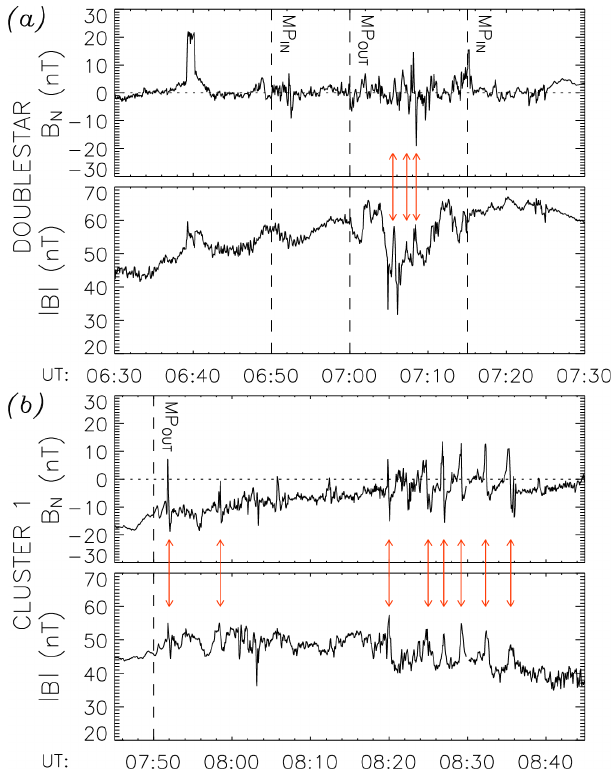
Fig. 3. Magnetic field measurements from the (a) TC-1 and (b) Cluster 1 spacecraft. The component of the magnetic field normal to the local magnetopause and the overall magnetic field strength are presented. Magnetopause crossings and FTEs discussed in the text are indicated by dashed lines and red arrows, respectively.